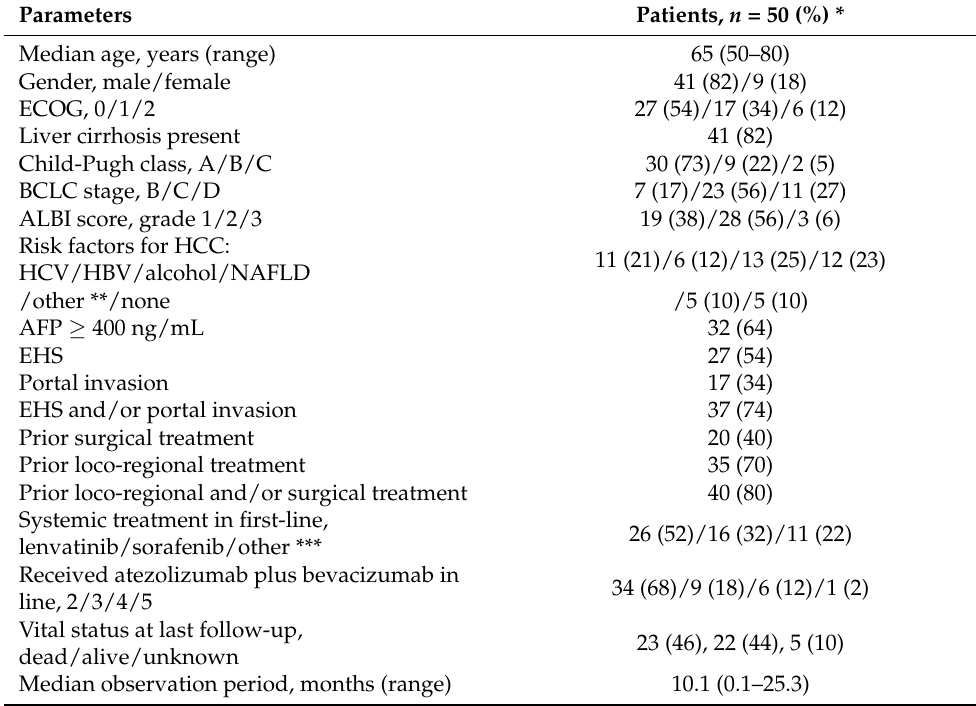
Table 1. Baseline